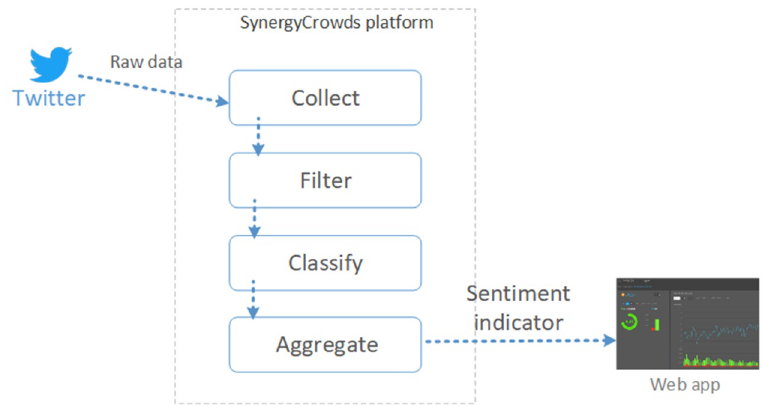
Figure 12. Execution flow of the sentiment